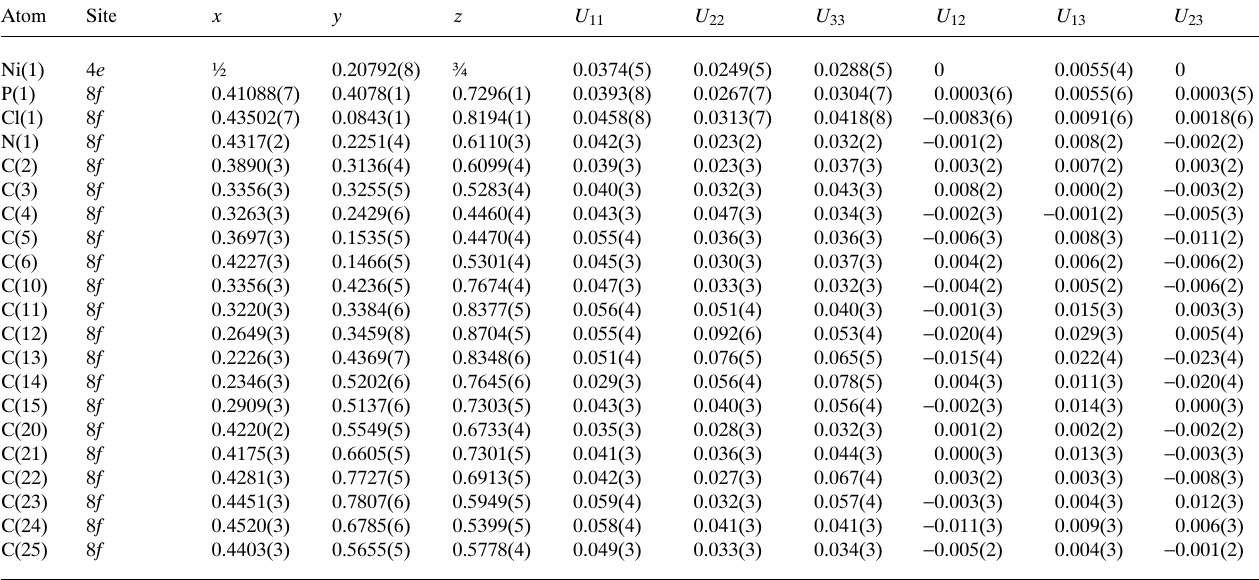
Table 3. Atomic coordinates and displacement parameters (in Å 2 )